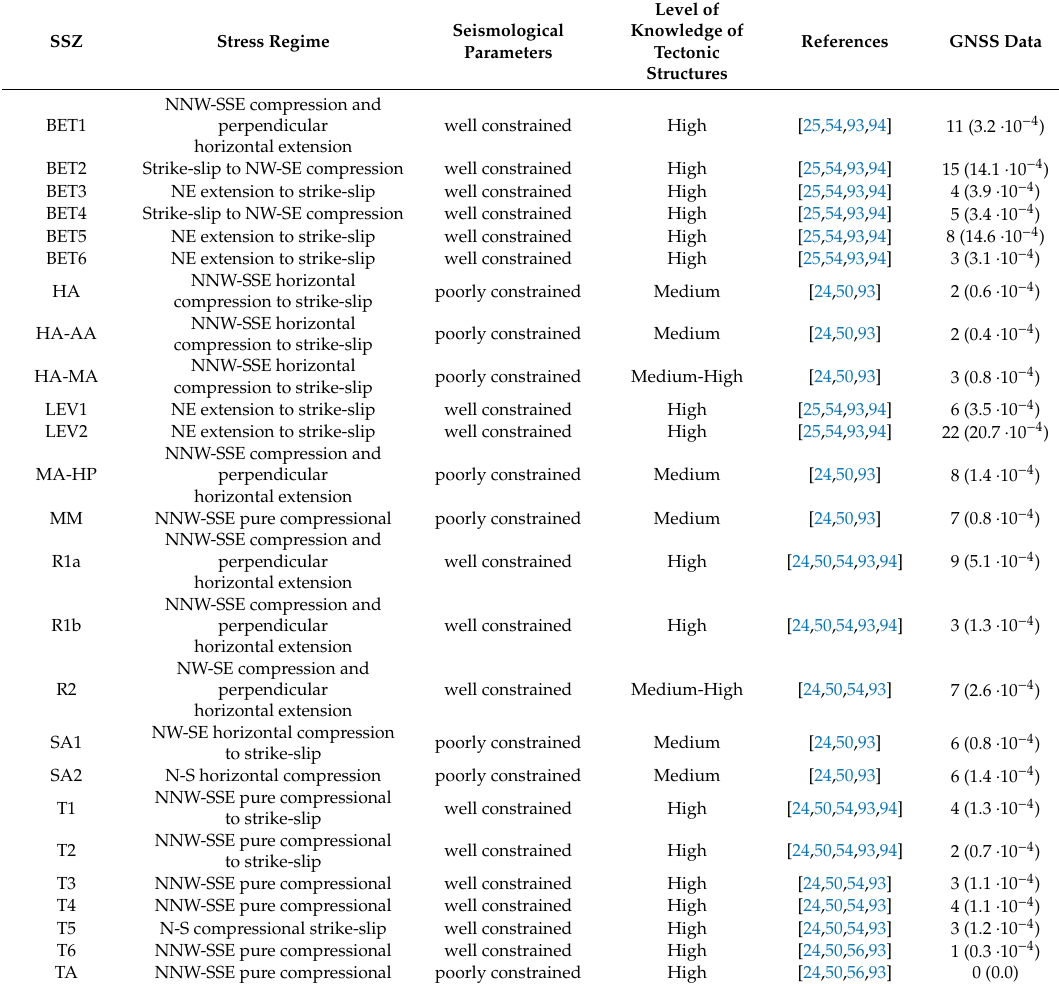
Table A1. Main features for each seismogenic source zone (SSZ) analyzed in this study. The last column reports the number of GNSS sites, and site density for km 2 (in brackets) for each SSZ.